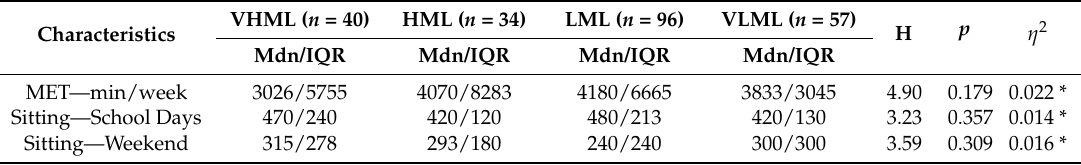
Table 1. The overall weekly physical activity and the average sedentary time on school and weekend days in participants according to the level of their school mental